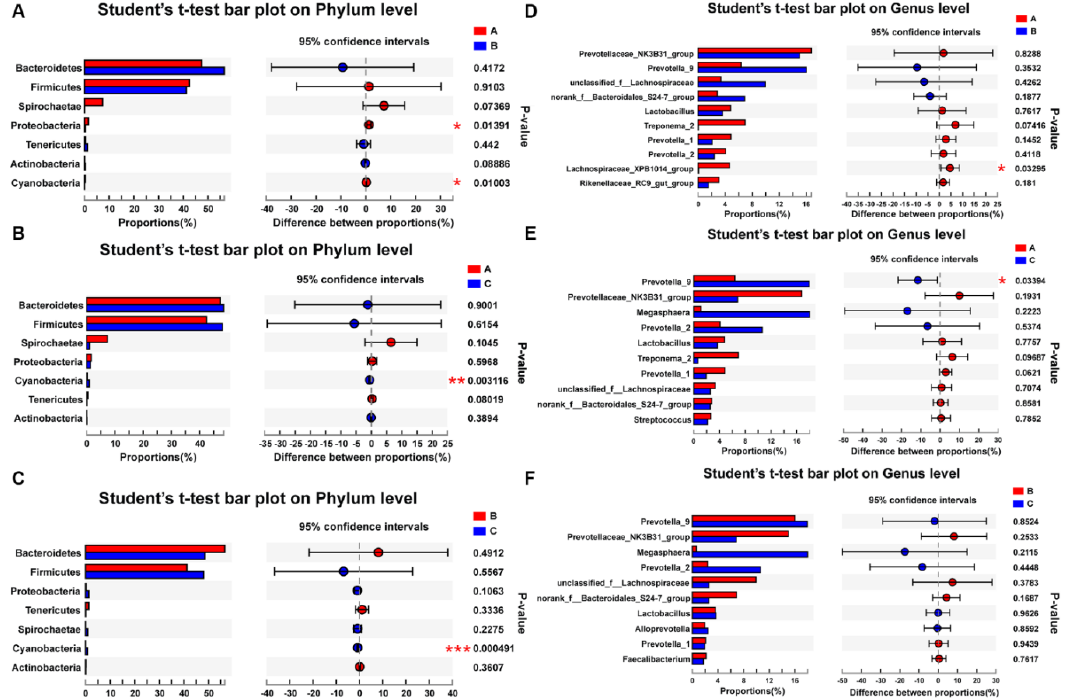
Figure 3. The different analyses of bacterial community at the phylum and genera levels. ( A – C ) The difference in bacterial community on the phylum level by Student’s t-test between groups A and B, between groups A and C, and between groups B and C, respectively. ( D – F ) The difference in bacterial community on the genera level by Student’s t-test between groups A and B, between groups A and C, and between groups B and C, respectively. * p ≤ 0.05, ** p ≤ 0.01, *** p ≤ 0.001. Group A: basal diet; group B: basal diet supplemented with antibiotics and zinc oxide; group C: basal diet supplemented with 0.06% CPB.